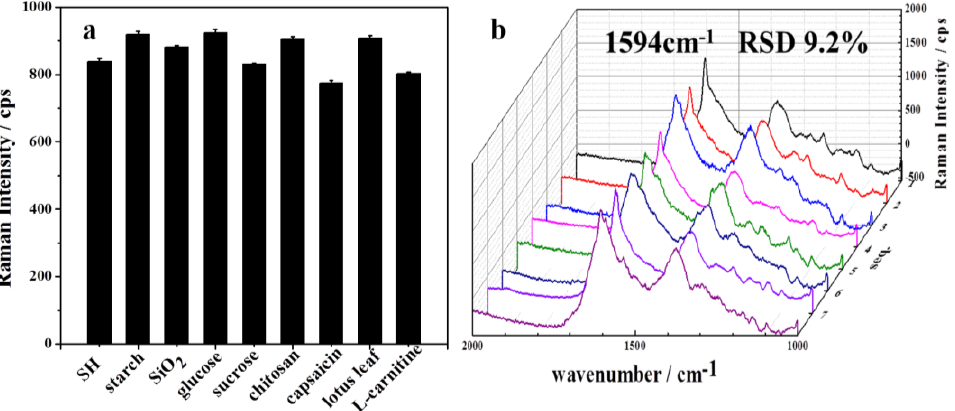
Figure 7. ( a ) Results of confirming the selectivity for SH detection; ( b ) SERS intensity (at the 1594 cm −1 peak) of 100 μg mL −1 SH on eight batches of β-CD-Ag/PVA substrates, five spots were randomly chosen for each batch of substrate.